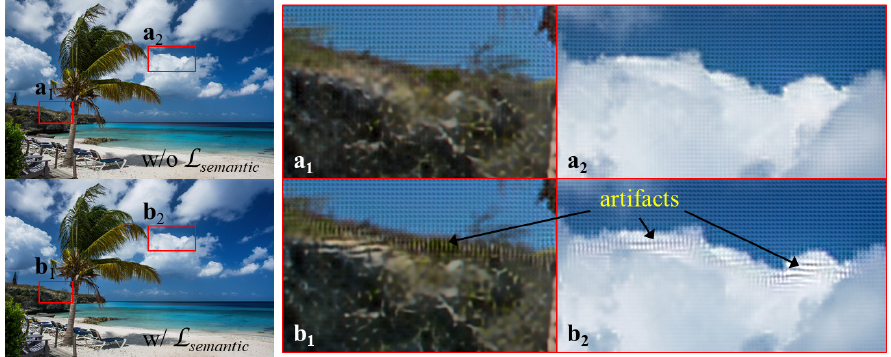
Figure 6. Visual comparison of non-text SR images with and without the semantic loss when training using